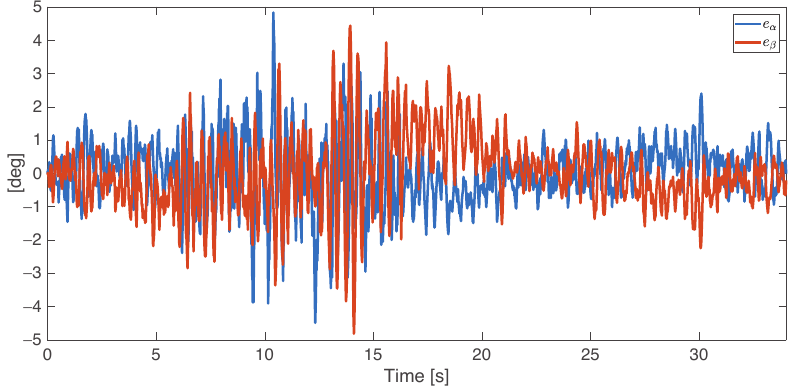
Figure 5. First case study: roll-pitch joint